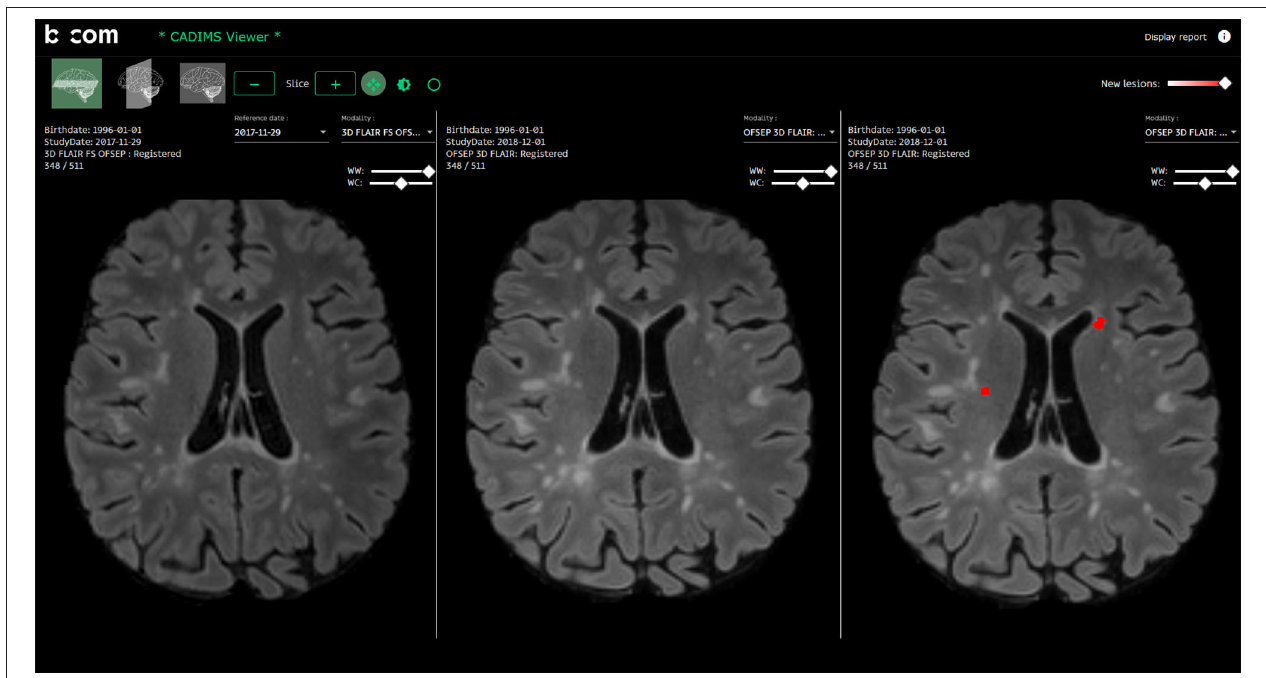
FIGURE 3 | The CADIMS viewer: The CADIMS MRI viewer is usable from a standard web browser. It consists of three synchronized views displaying from left to right (i) the baseline scan, (ii) the follow-up scan and (iii) the follow-up scan with segmented new lesions highlighted in red.